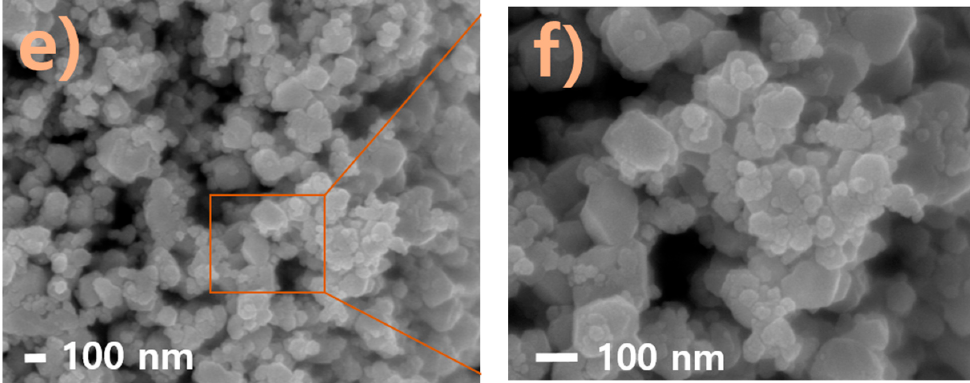
Figure 2. Field-emission scanning electron microscope (FESEM) images of synthesized nanoparticles at di ff erent extract ratios: ( a ) AgNP at 1:1 ratio; ( b ) magnified image of 1:1; ( c ) AgNP–Ag 2 ONP at 1:2 ratio; ( d ) magnified image of 1:2; ( e ) Ag 2 ONP at 1:4 ratio; ( f ) magnified image of 1:4.